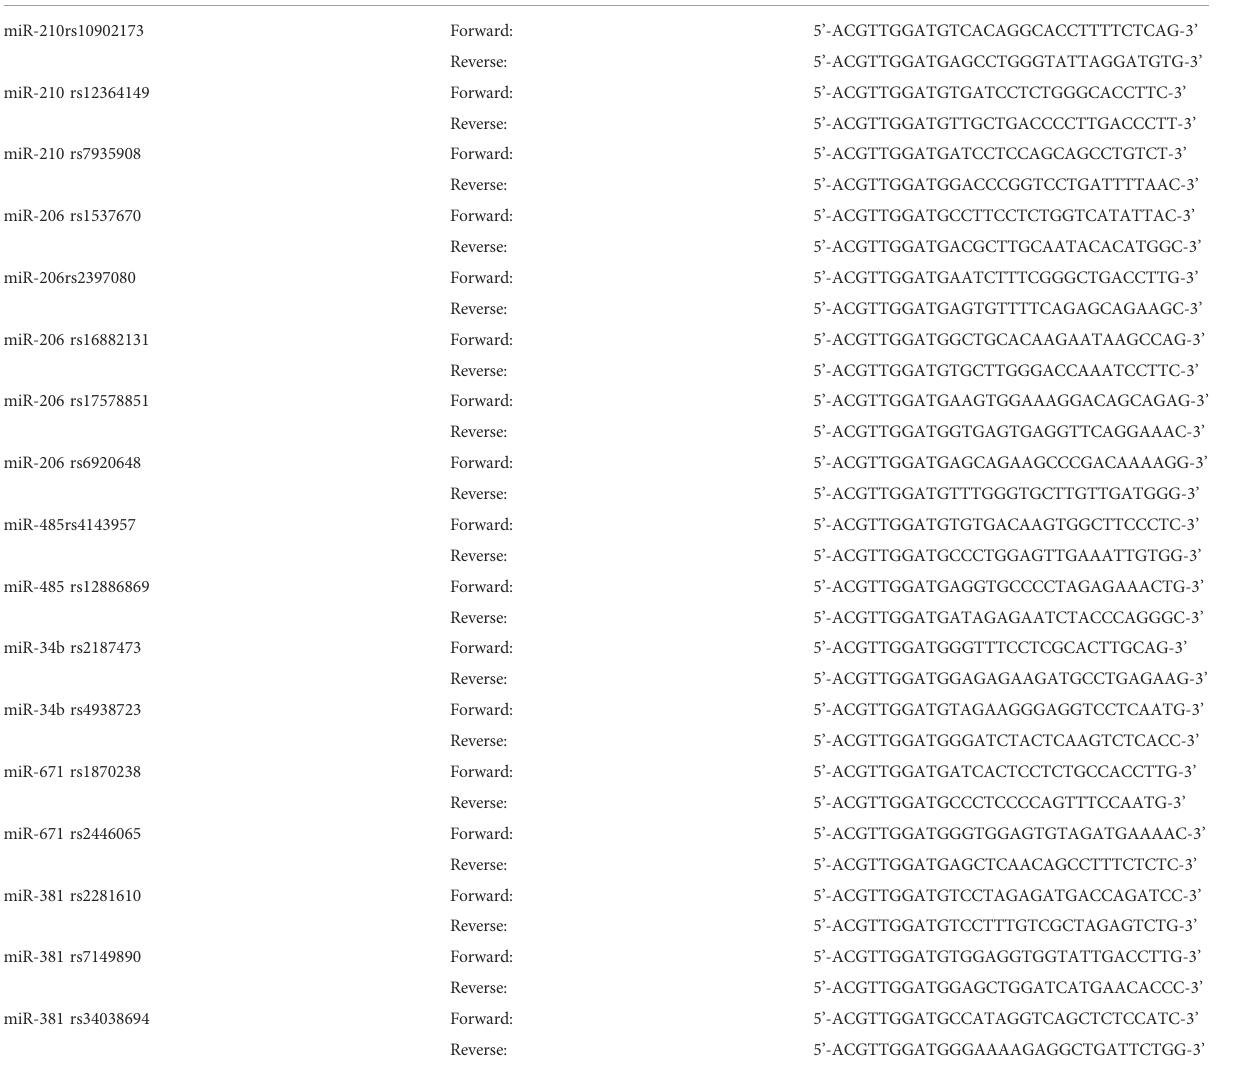
TABLE 1 Primers sequences for miRNA gene